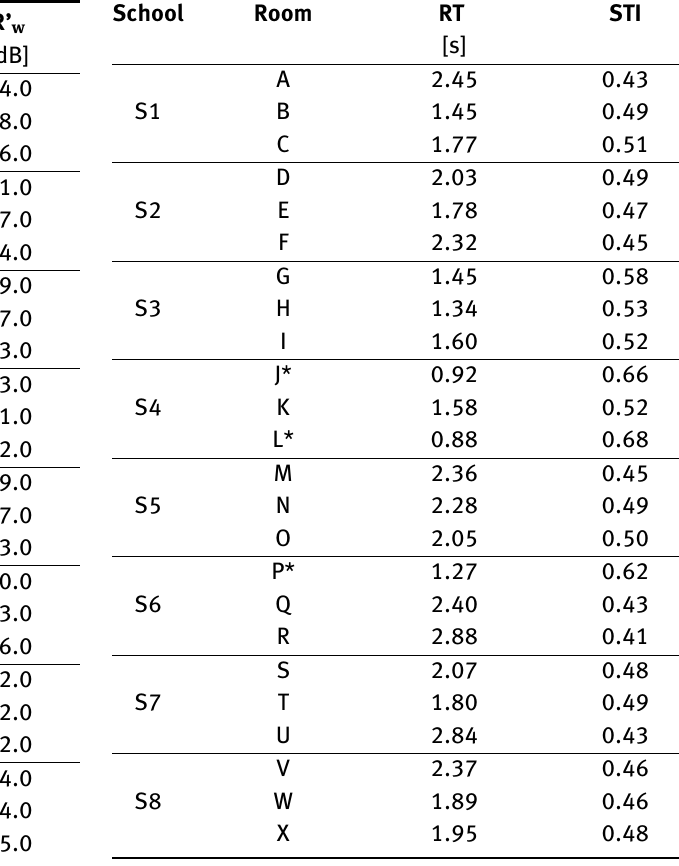
Table 6: Vertical partitions insulation.